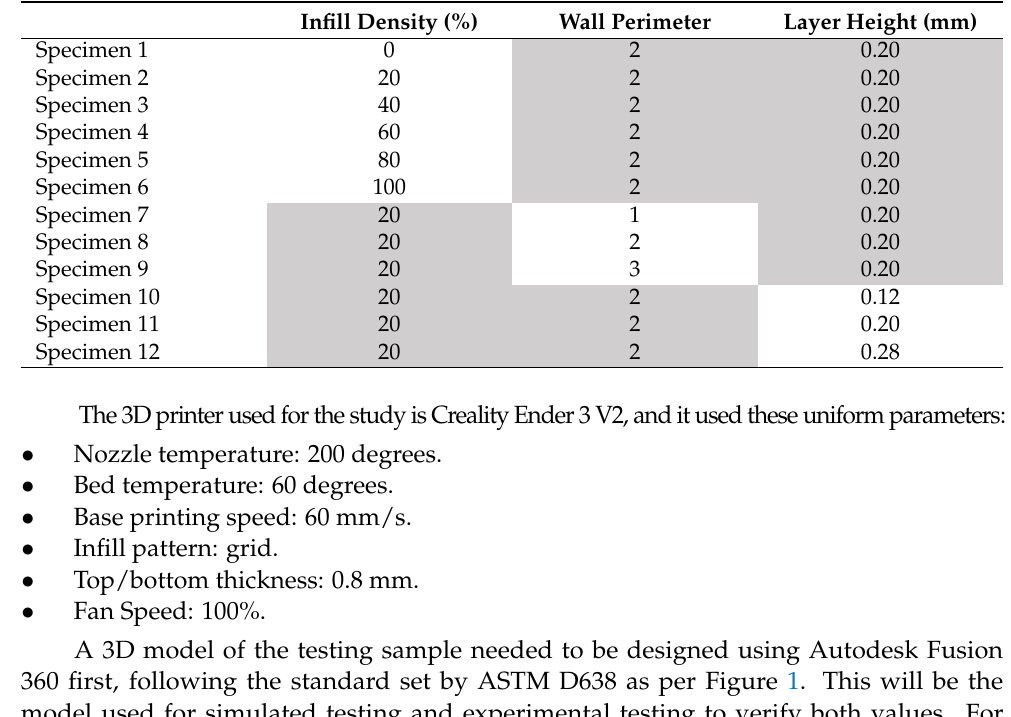
Table 1. Coded specimen according to parameters (darkened section is fixed parameter).